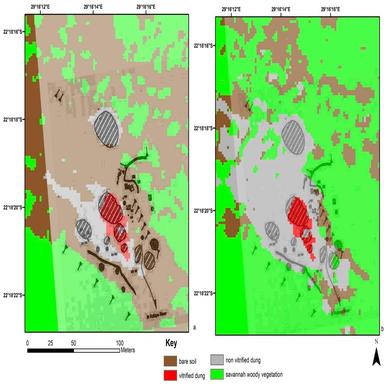
Plan of site AD4 drawn by overlaid on both RF (a) and SVM (b) classified images. Dark circles represent possible midden areas, solid lines represent stone walls while circular features with lines across represent kraals.